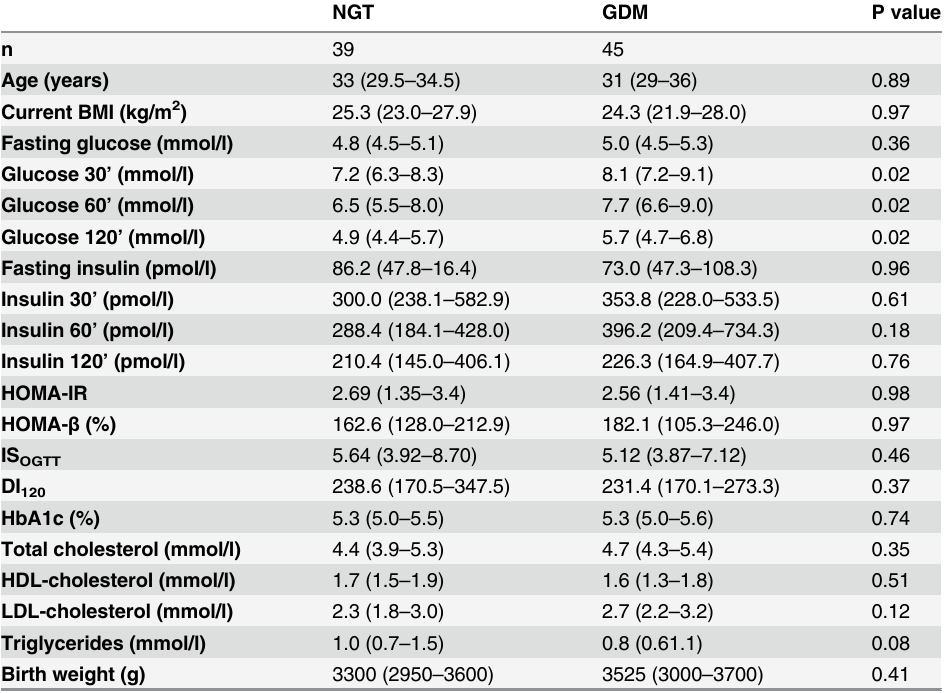
Data are shown as medians (interquartile range), NGT, normal glucose tolerance, GDM, gestational diabetes mellitus, differences between NGT and GDM groups were analyzed by Mann-Whitney U